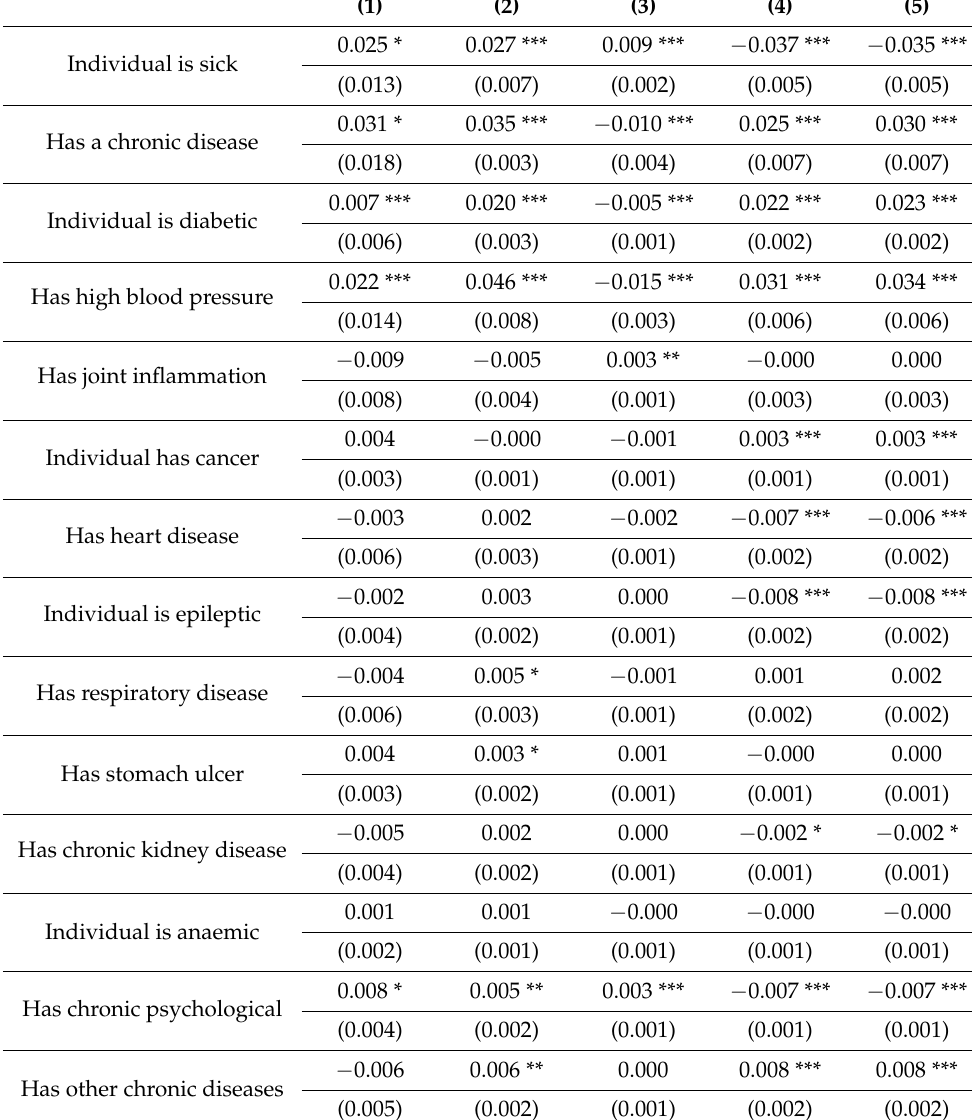
Table 3. Income-related, tobacco-related and alcohol-related health